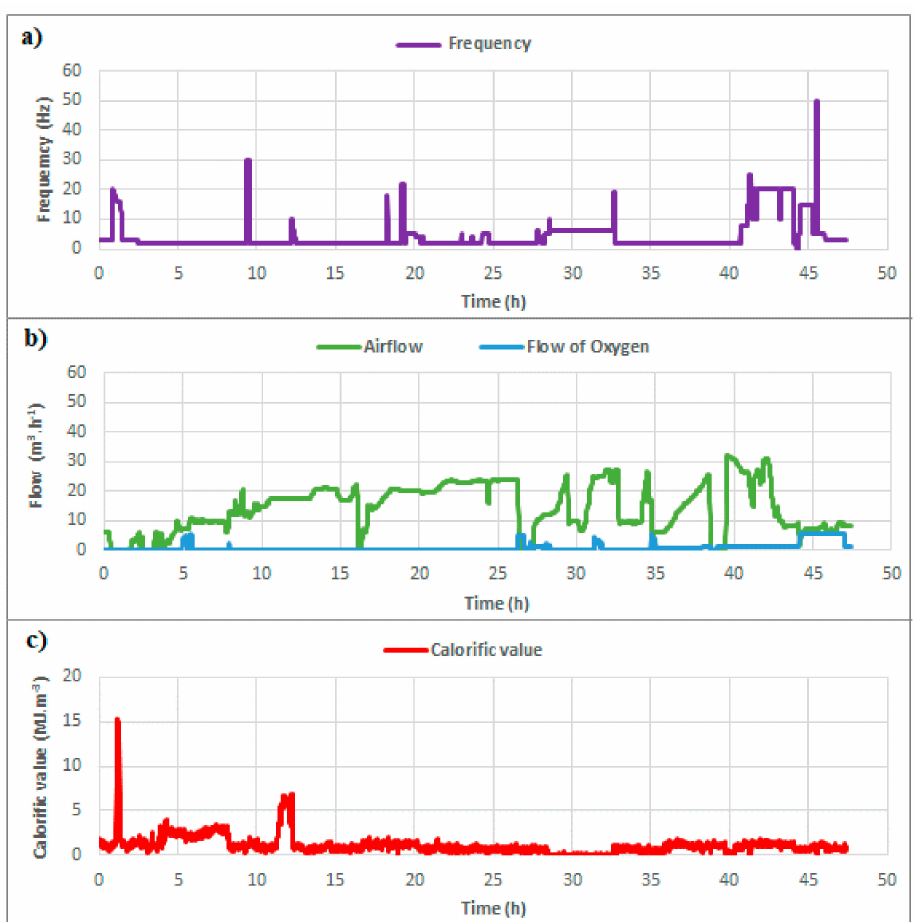
Figure 8. The measured data behaviors in the first experiment: ( a ) the exhaust fan motor frequency, ( b ) the air and oxygen, and ( c ) the calorific value (Source: own